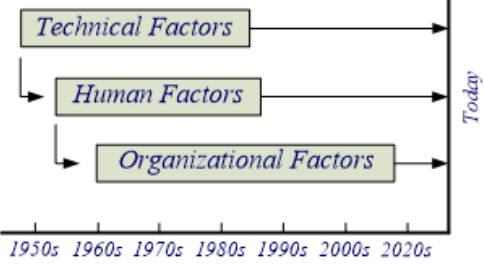
Figure 1. The evolution of the SMS through